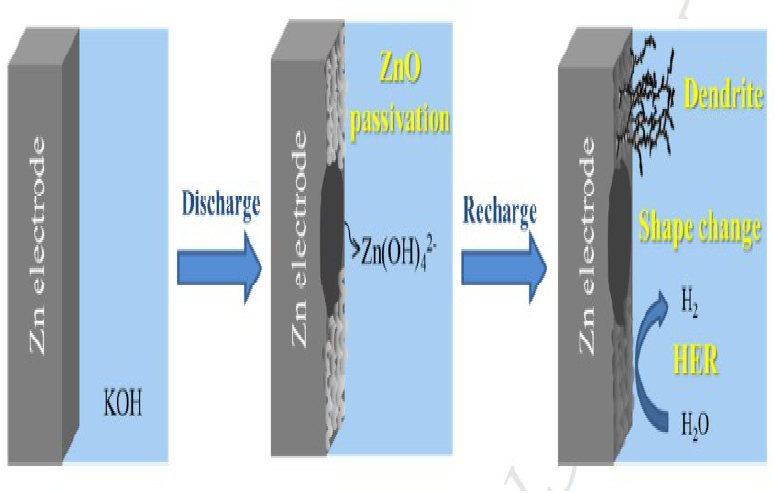
Figure 2. Schematic of the Zn electrode ’ s dendrite phenomenon and the rechargeable limitation of the zinc electrode.